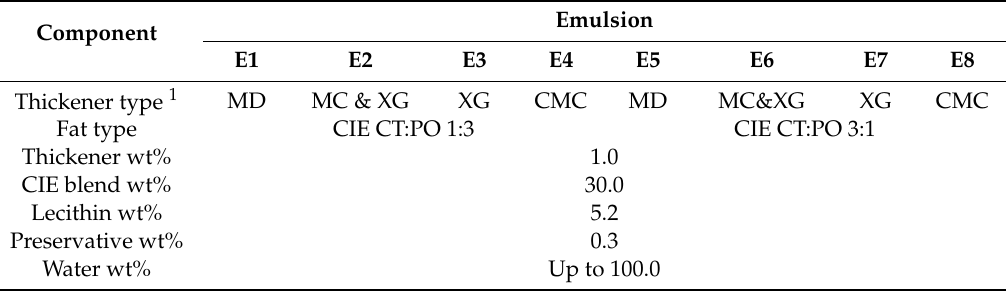
Table 1. Compositions of the